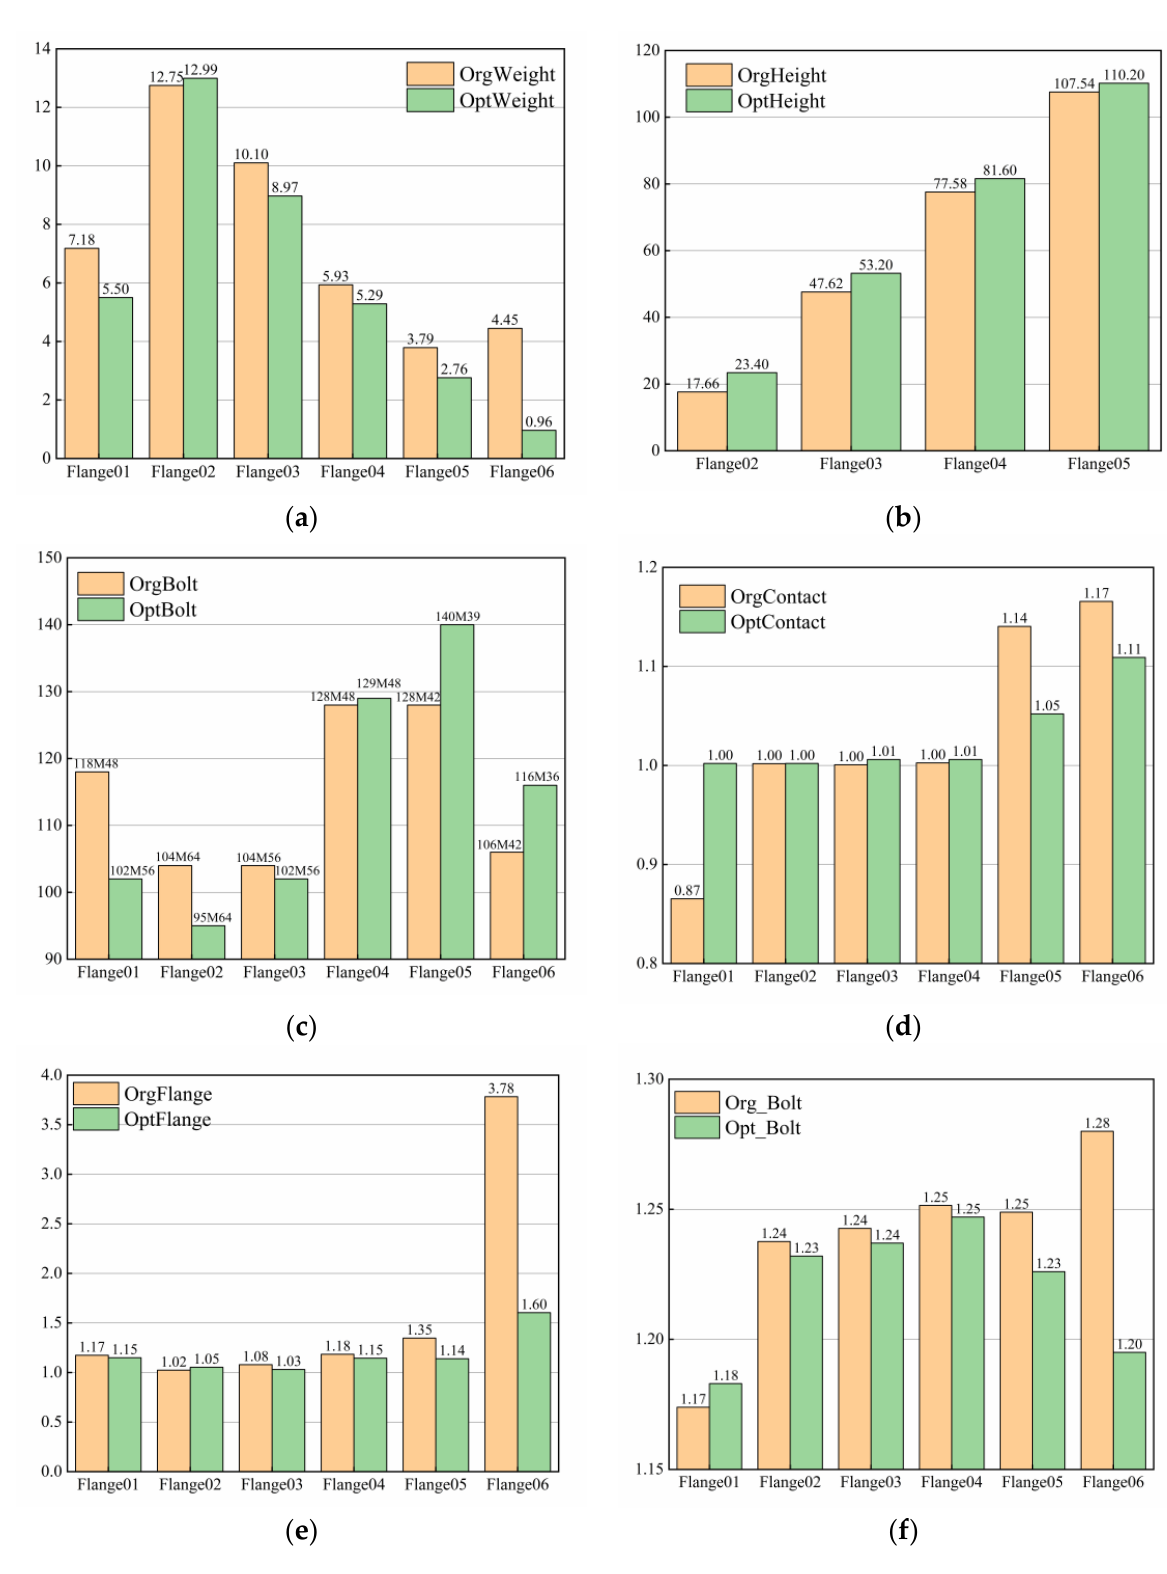
Figure 6. Property and safety factors of original and optimum 2MW bolted connections and flanges. ( a ) Weight of flanges; ( b ) Height of flanges; ( c ) Bolt settings; ( d ) Safety factors of contact; ( e ) Safety factors of flange strength; ( f ) Descrip Safety factors of bolted connection.